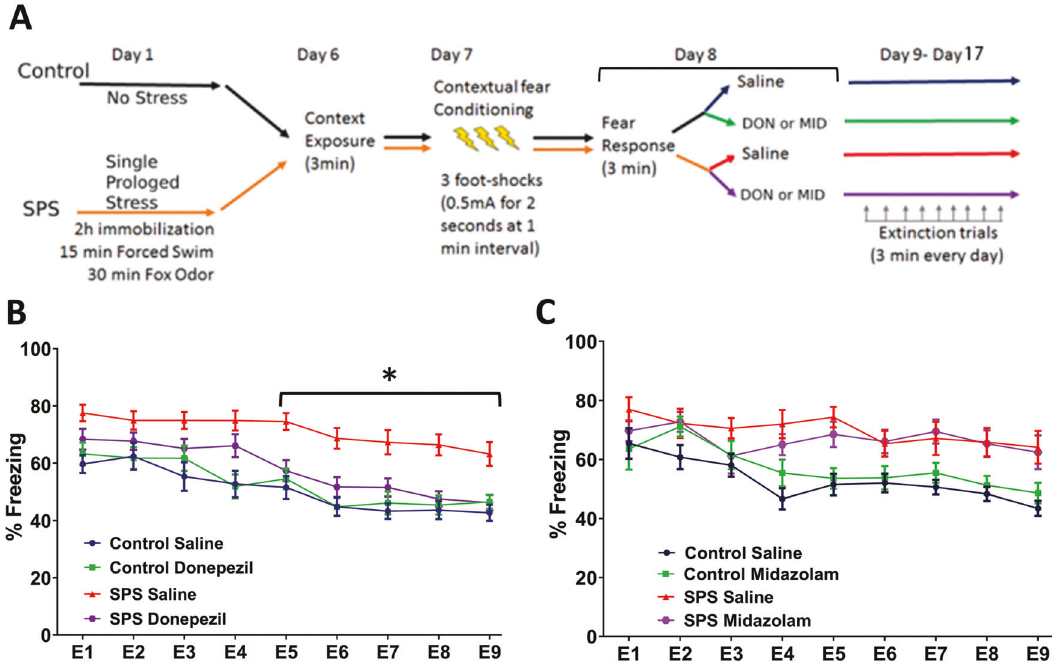
Fig. 5 Donepezil augments fear extinction in a mouse model of PTSD-like behavior. A Schematics diagram of the SPS model used for contextual conditioning and extinction paradigm. Freezing time to context after induction of fear in WT mice was measured for 9 consecutive days in extinction-learning trials whereby the animals were re-exposed to the context for 3 min/day without receiving the foot shock. B Donepezil treatment during the extinction trials reduces freezing behavior in the SPS model. WT mice were treated each day with donepezil starting at day 8 after measuring the fear response and each following day immediately after each extinction trial. Note the overall higher freezing time in saline-treated stressed group. In contrast, donepezil-treated SPS group mice could extinguish their fear from the 5th extinction trial onwards similarly to the non-stressed animals. * p < 0.05, n = 18 – 22/group, statistical analysis by two-way ANOVA followed by Tukey ’ s post-hoc multiple comparison test. C Treatment of animals with the GABA agonist midazolam does not affect fear extinction relative to the SPS saline group ( n = 8 – 12/group). Note that neither donepezil nor midazolam affects extinction learning in condition of non-stress (Control Donepezil in B and Control Midazolam in C relative to Control